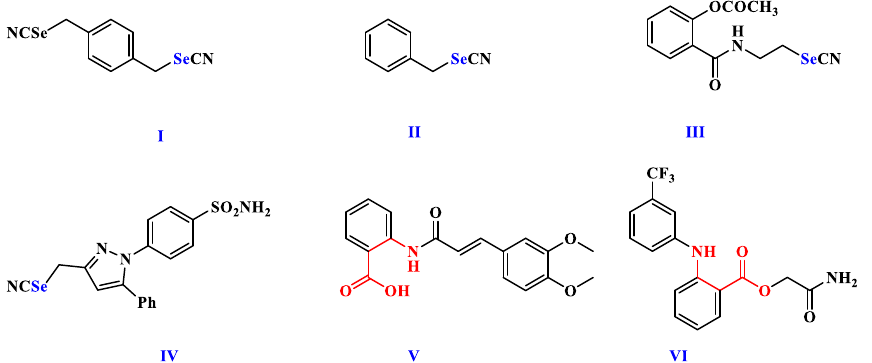
Figure 1. The structure of biologically relevant organoselenium and anthranilic acid analogs.